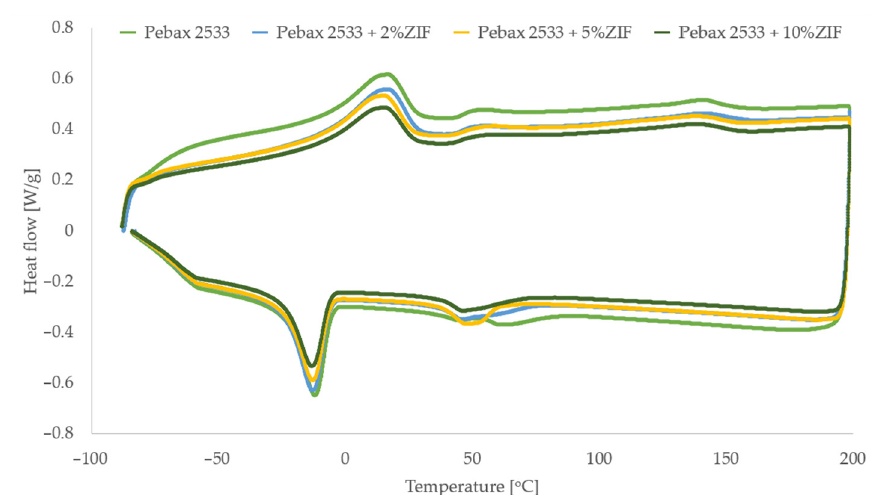
Figure A1. DSC thermogram for membranes containing ZIF − 8 in different concentrations.